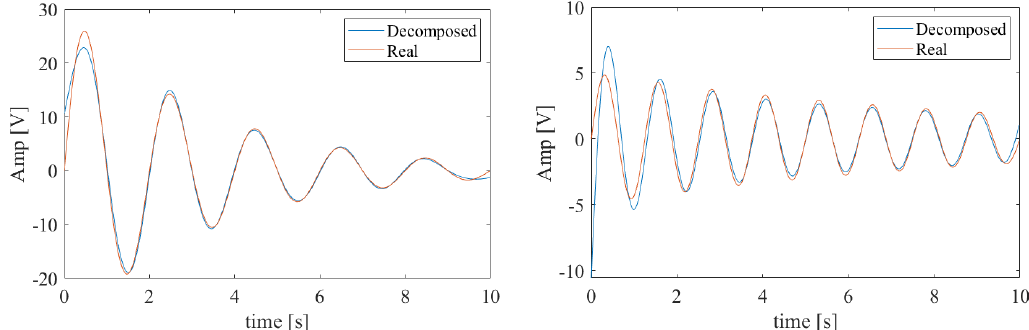
Figure 4. Mono-components obtained from the signal of Equation (17), setting the bisecting frequency equal to the minimum of the spectrum;low frequency signal ( on the left ) and high frequency signal ( on the right